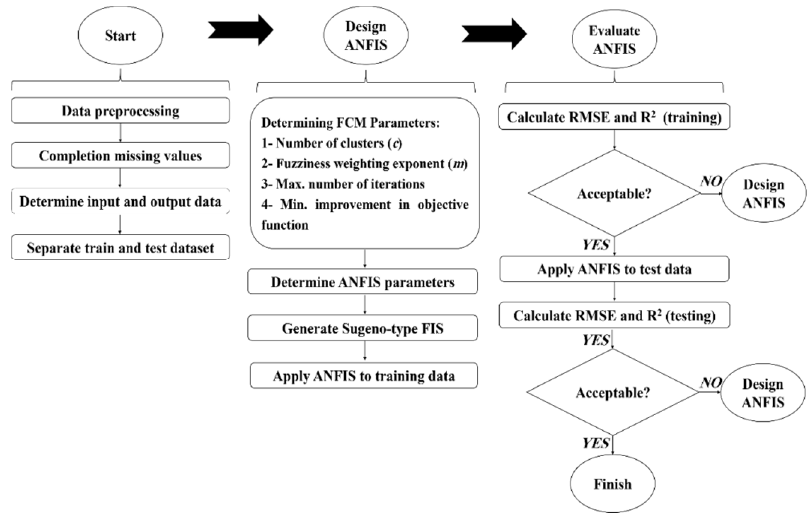
Figure 6. Flow diagram of the combination of fuzzy c-means clustering (FCM) method and ANFIS [11].